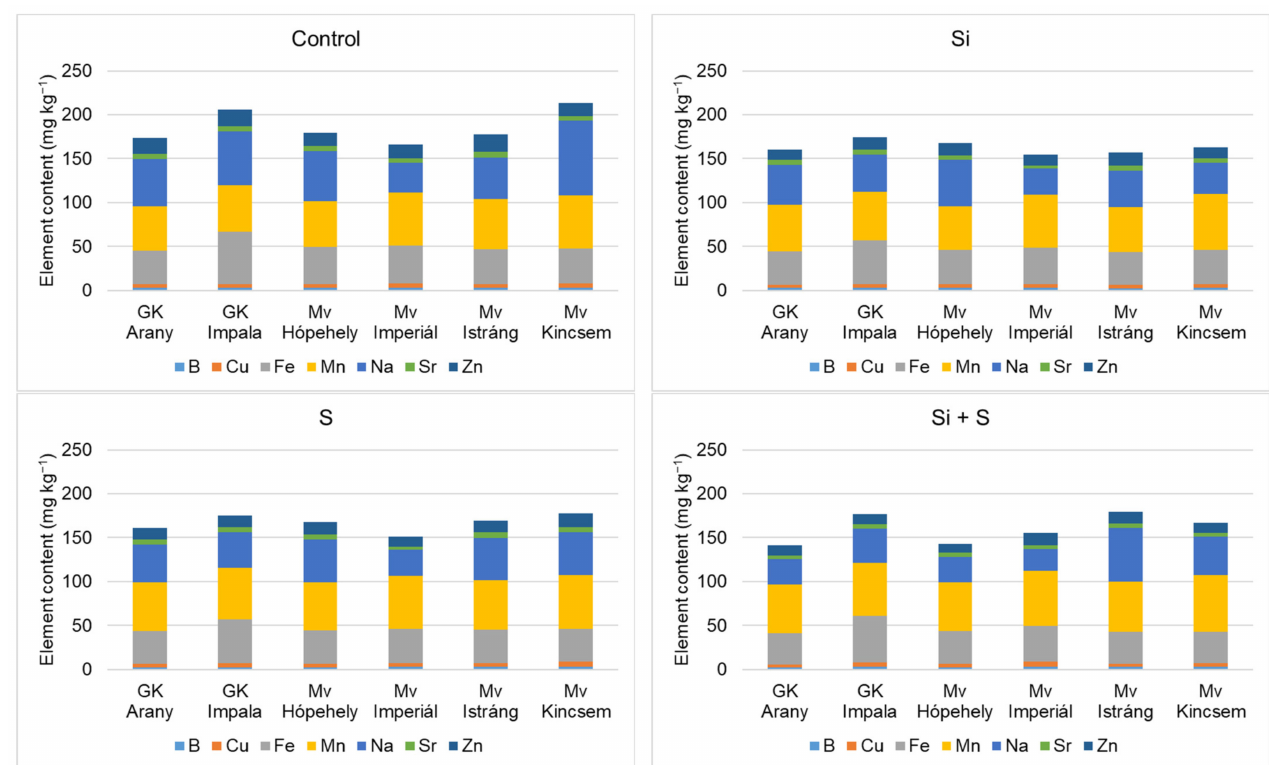
Figure 10. Whole grain B, Cu, Fe, Mn, Na, Sr, and Zn contents of the winter oat varieties as a function of the foliar fertilisation